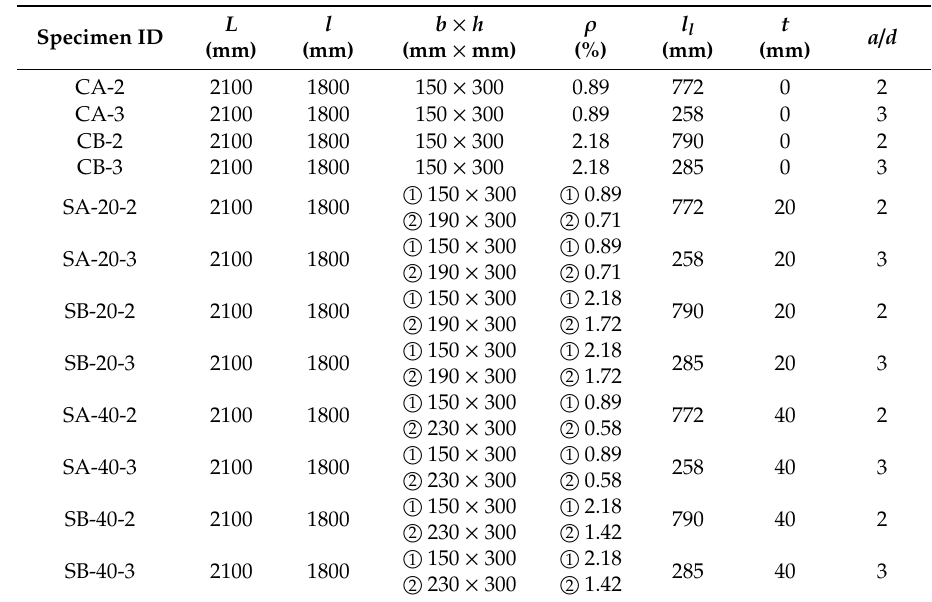
Figure 3. Sketch of the specimens (mm). Table 2. Beams